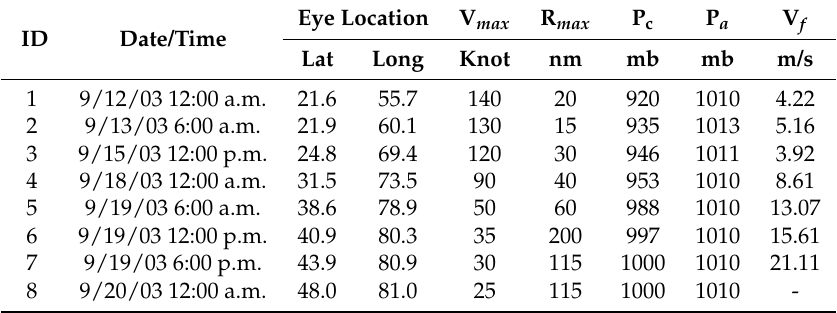
Table 1. Hurricane Isabel characteristics at a time 161 h before until 31 h after the